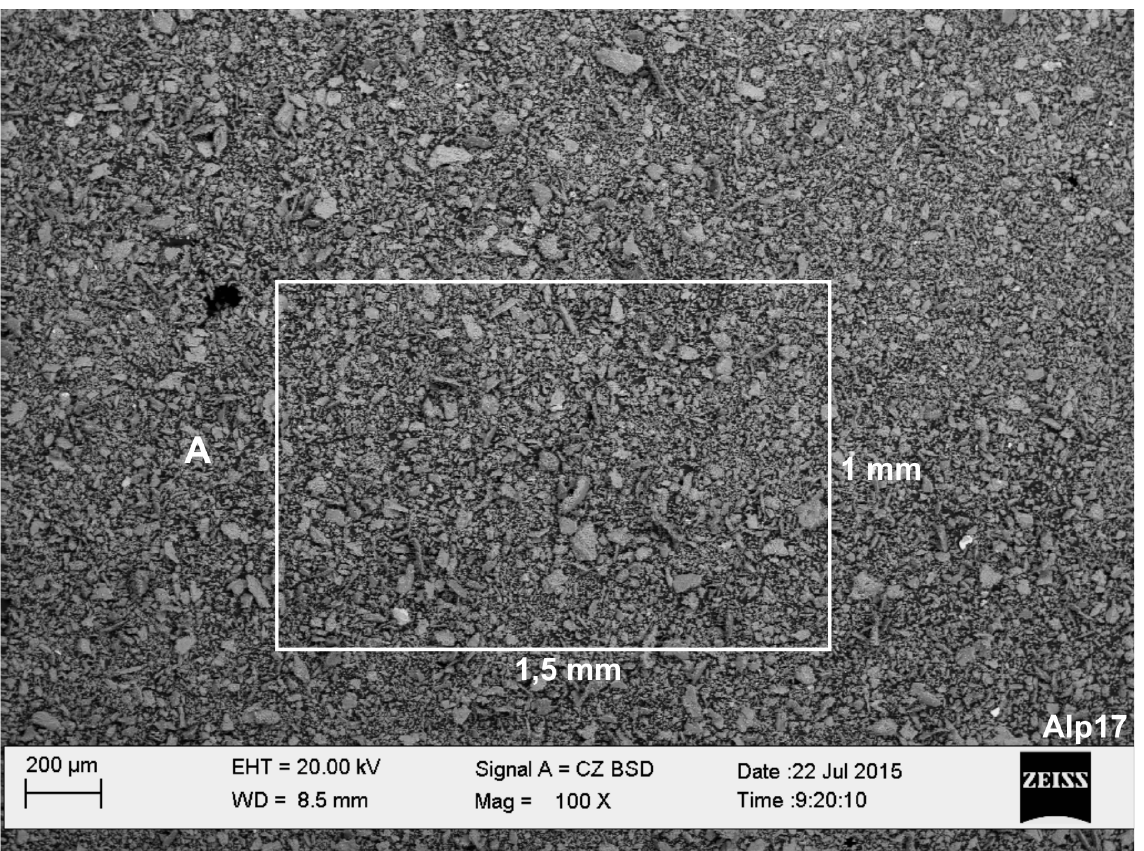
Figure 8. Electronic microphotography of the powder sub-samples extracted with the micromotor. A: size of the scanned area analysed in EDX. Produced by A.